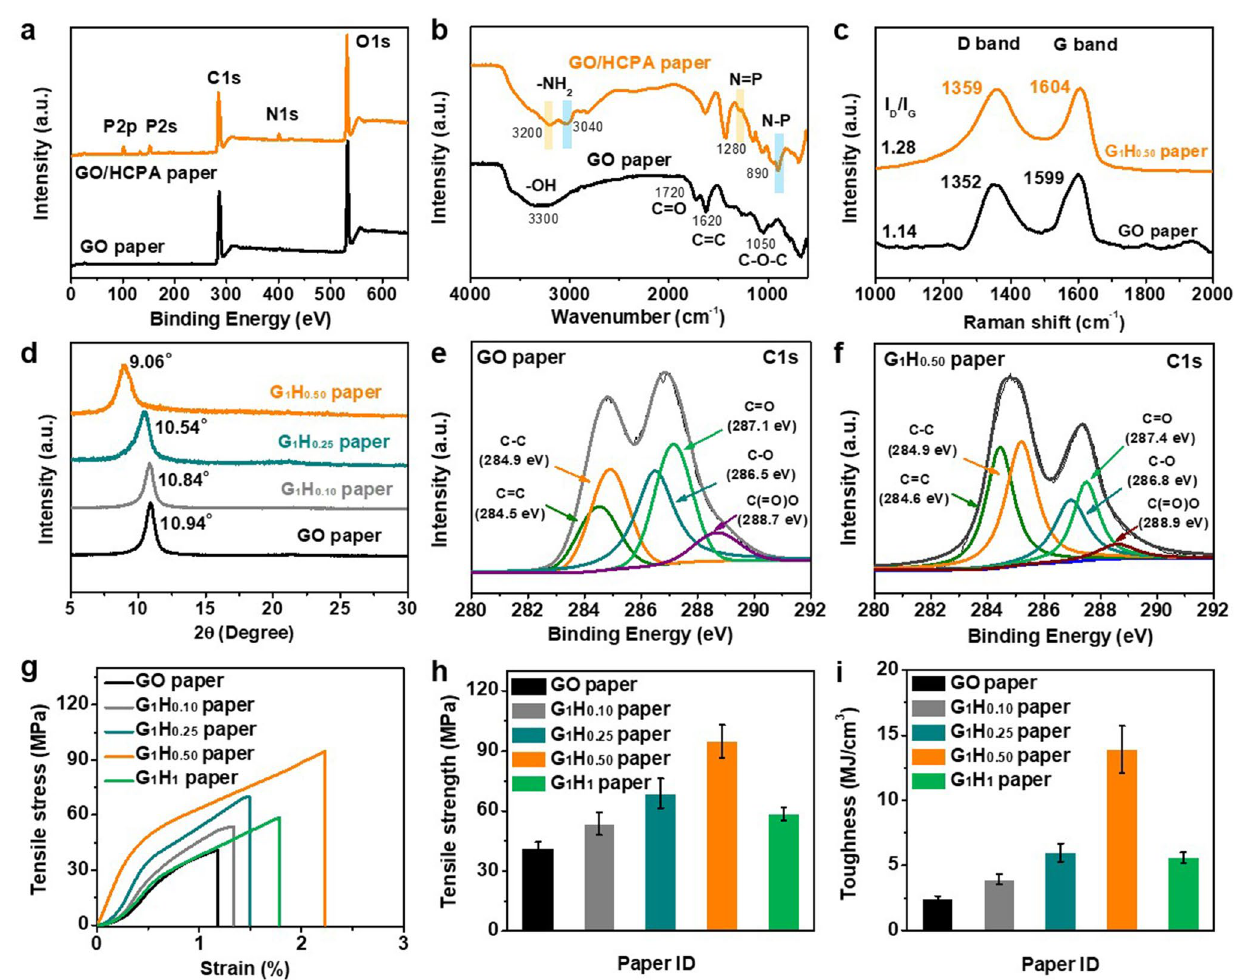
Fig. 2 Interaction characterization and mechanical properties. a XPS results, b FTIR, and c Raman spectra of GO paper and G 1 H 0.50 paper. d XRD patterns of various GO/HCPA papers. XPS C 1 s spectra of e GO paper and f G 1 H 0.50 paper. g Tensile stress–strain curves, h tensile strength and i toughness of pure GO paper and various GO/HCPA composite papers, confirming the multi‑interaction between GO and HCPA